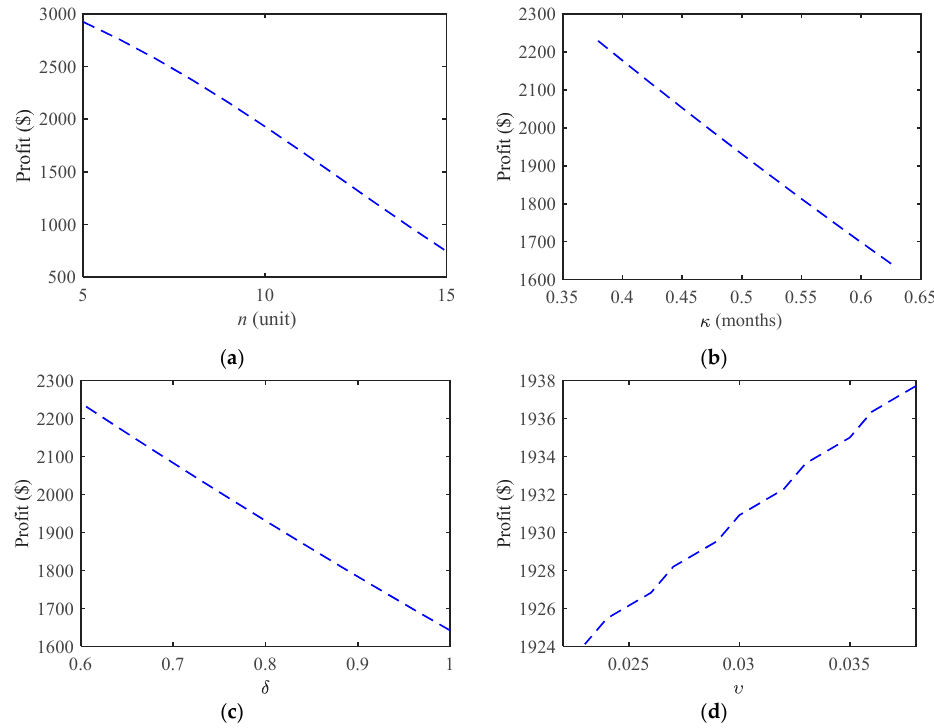
Figure 10. Total profit profile associated with instalment-based payment-in-advance parameters. ( a ) describes the total profit against the number of instalments, ( b ) shows the total profit for different lead times, ( c ) describes the profit vs. payment in advance portion, and ( d ) describes the total profit for different discount rates due to instalment based payment in advance.